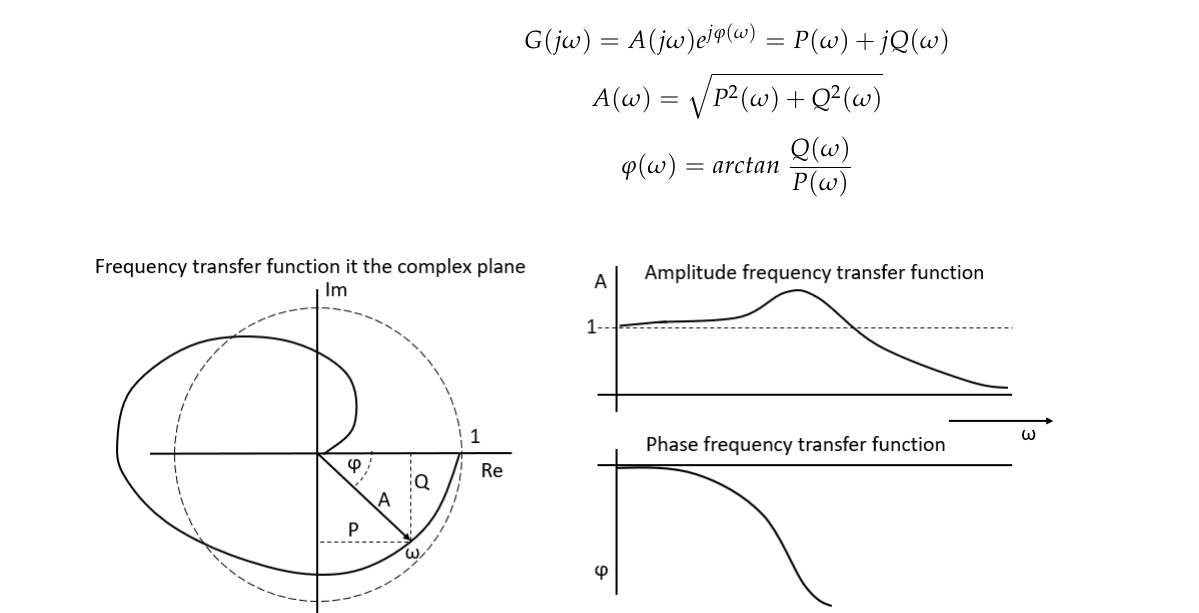
Figure 6. Different ways of displaying the transfer function.